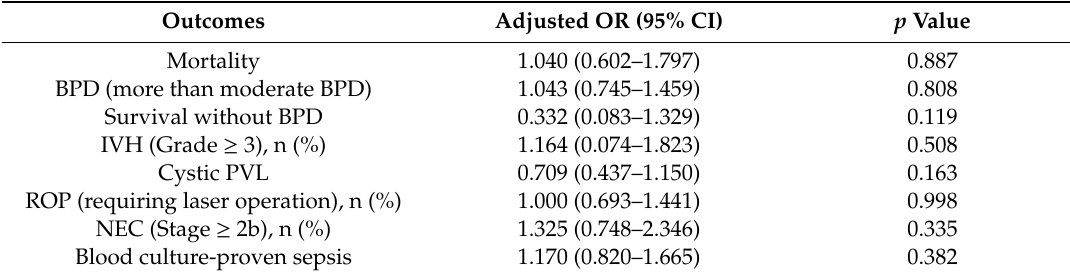
Table 5. Adjusted ORs * for risk of adverse outcomes by duration (per week) of stage 3